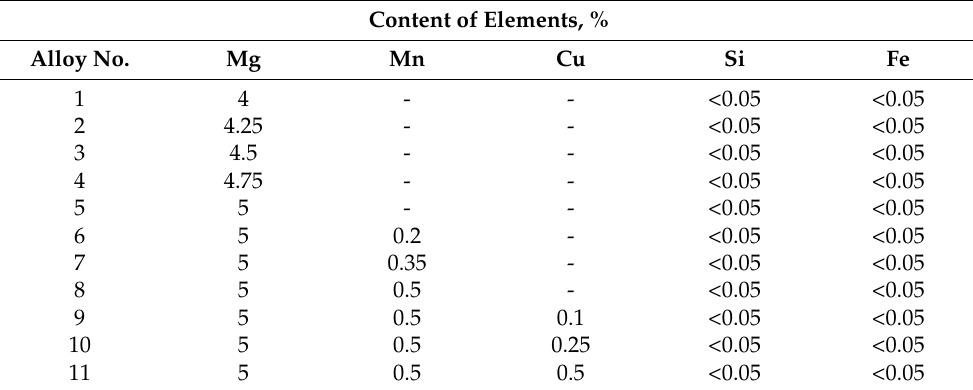
Table 1. Chemical compositions of the investigated Al-Mg alloys.